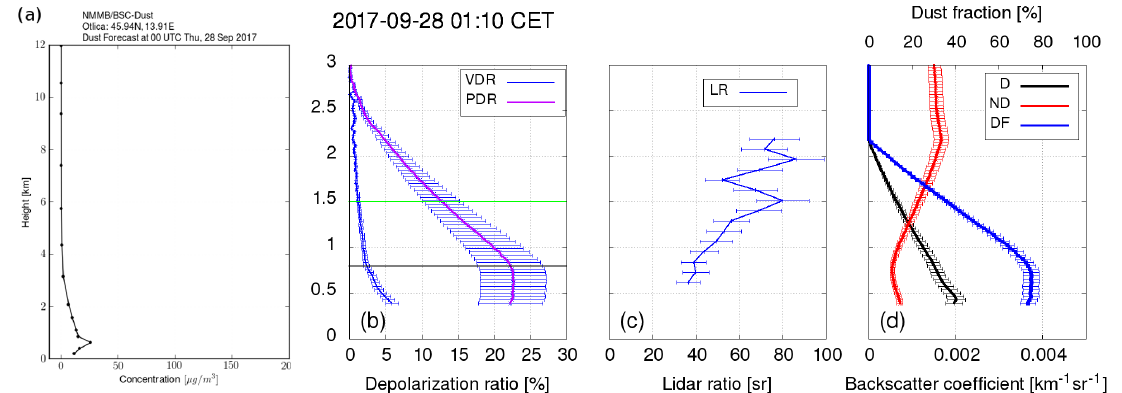
Figure 13. ( a ) The NMMB-BSC-DUSTmodel forecast of mineral dust concentration and its vertical distribution over the Vipava valley at 01:00 CET on 28 September 2017 (https://ess.bsc.es/bsc-dust- daily-forecast), ( b ) VDR and PDR, ( c ) LRat 355nm, and ( d ) Dust Fraction (DF) and backscatter coefficients for Dust (D), Non-dust (ND) Aerosols. (b–d) were obtained from LiDAR measurements on 28 September 2017, 01:10–01:40 CET. Error bars stand for the estimated uncertainties. The two horizontal lines (black and green) represent the top of the PBL and the height of the elevated aerosol